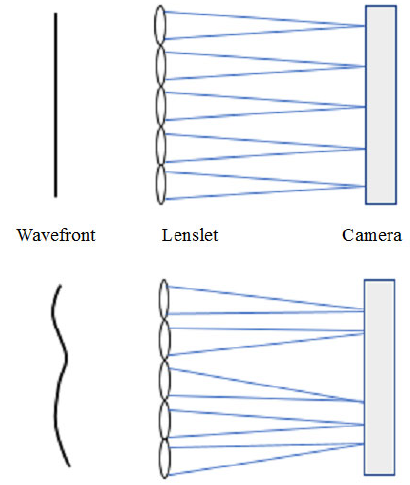
Fig. 1 Schematic of focal spot displacement in a Shack-Hartmann wavefront sensor.